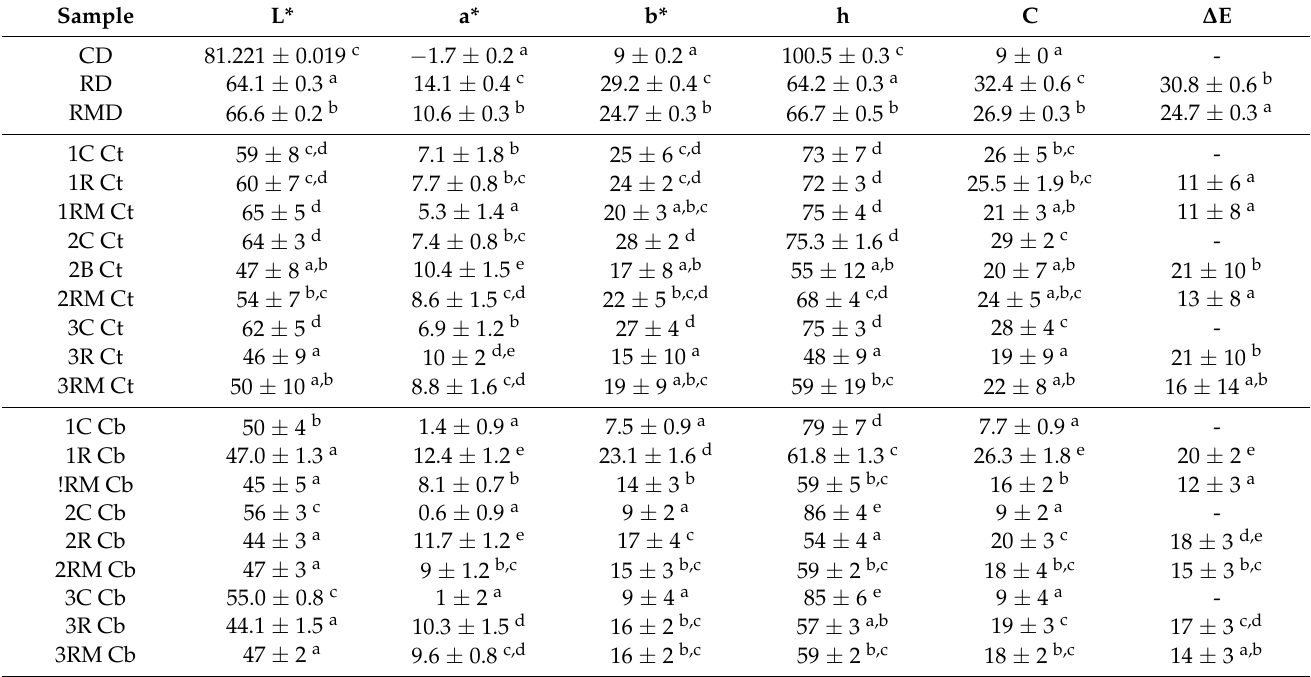
Table 3. Color parameters of the samples for a D65 illuminant and 10 ◦ observer (D, dough; Ct, crust; Cb, crumb B control; E, rosehip; EM, rosehip maltodextrin; 1, 2, 3 cm